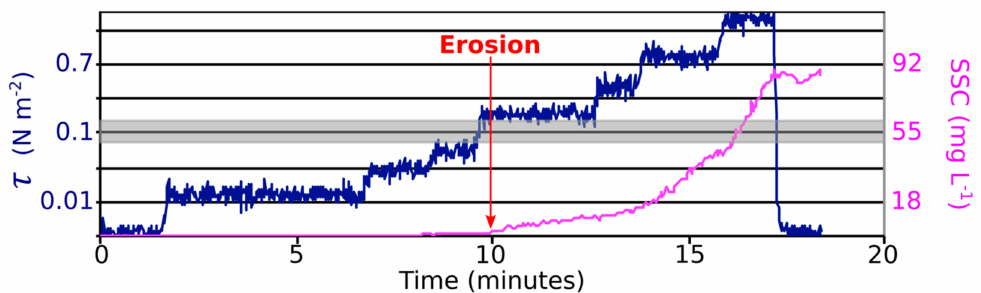
Figure 4. Erodimetry experiment conducted on a muddy sample of the BoBCS using the “erodimeter” device [7]. On the graph, the blue and pink curves represent time evolutions of bottom shear stress (N · m − 2 ) and suspended sediment concentration ( SSC in mg · L − 1 ) during the few minutes of the experiment. The applied shear stress at which erosion begins (around 0.1 N · m − 2 ) is illustrated by a grey